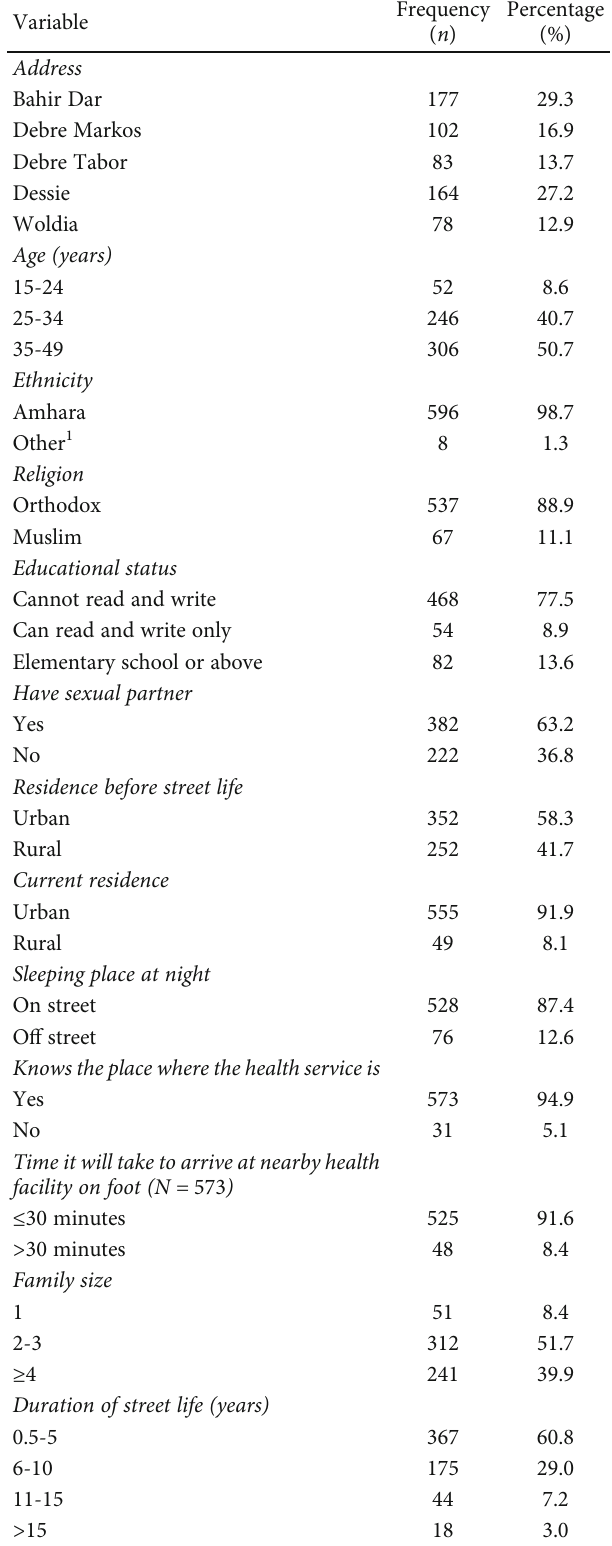
Table 1: Sociodemographic characteristics of respondents in